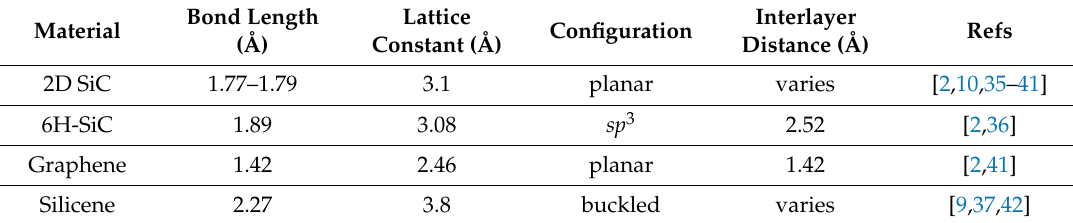
Table 1. Structural characteristics of 2D SiC and other related